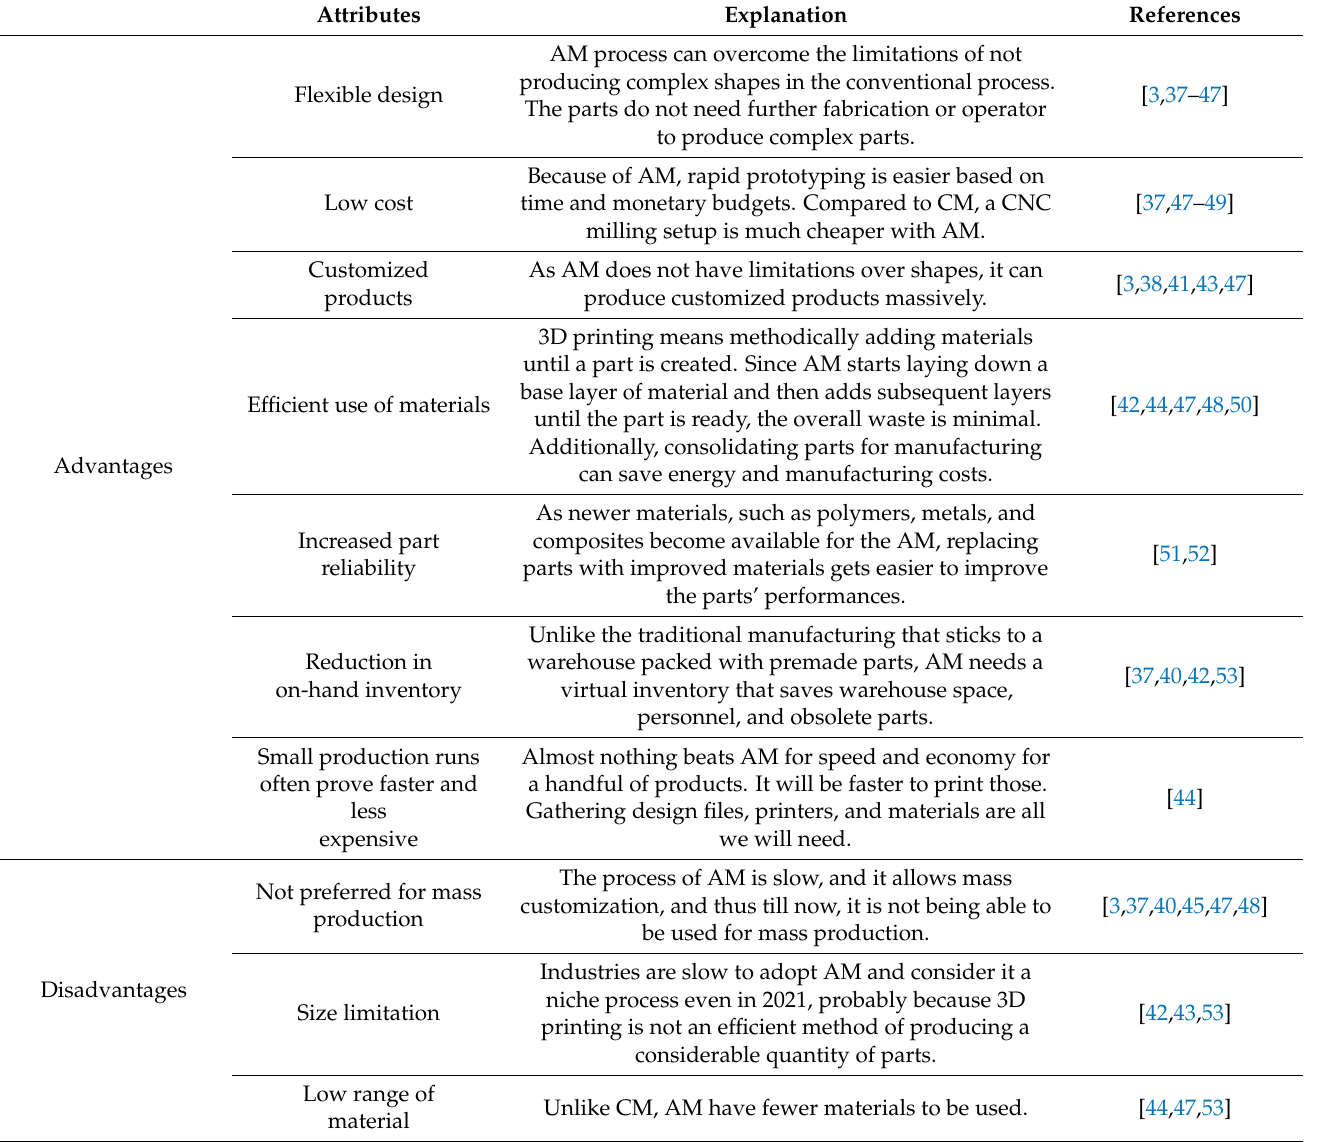
Table 5. The advantages and disadvantages of AM over